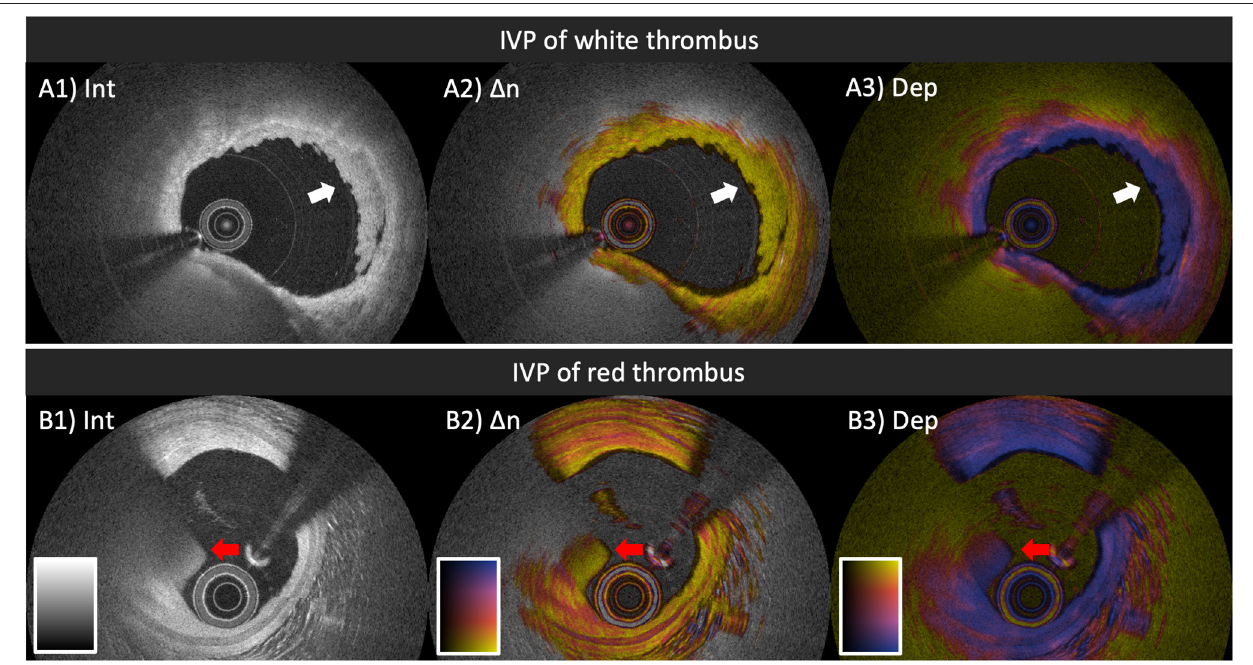
FIGURE 5 | IVP of thrombi in patients with ACS. (A1–A3) White thrombus (white arrow) attached to the luminal surface, exhibiting homogeneous backscattering and low attenuation (A1) , paired with low birefringence (A2) and low depolarization (A3) . (B1–B3) Red thrombus (red arrow) protruding into the lumen, featuring high backscattering, and attenuation (B1) , together with relatively low birefringence (B2) and gradually increasing depolarization (B3) . IVP, intravascular polarimetry.